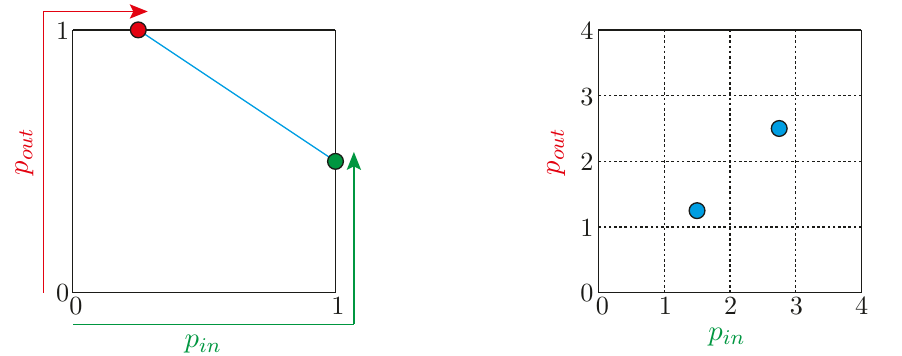
Figure 15 . Our parametrization of all possible straight lines intersecting the unit square in terms of the coordinate p in of the entry point and the coordinate p out of the exit point, where p in ( p out ) is measured counterclockwise (clockwise) along the perimeter. The right panel shows the complete ( p in , p out ) parameter space, which is a square of side length 4. The blue dot represents the blue example line shown in the left panel and its partner (when the line is traversed in